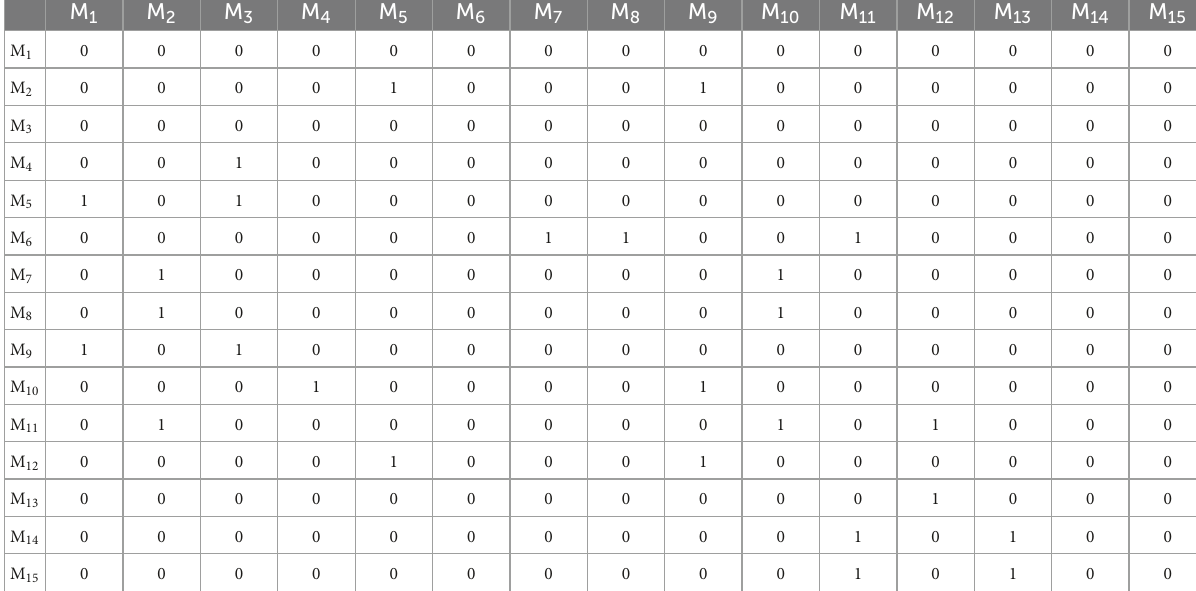
TABLE 1 Adjacency